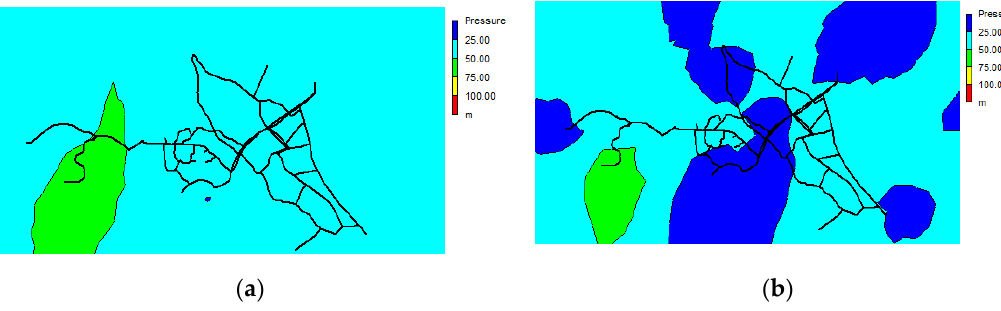
Figure 15. The comparisons of pressures without PAT ( a ) and with four PATs ( b ) at demand pattern 1.34.